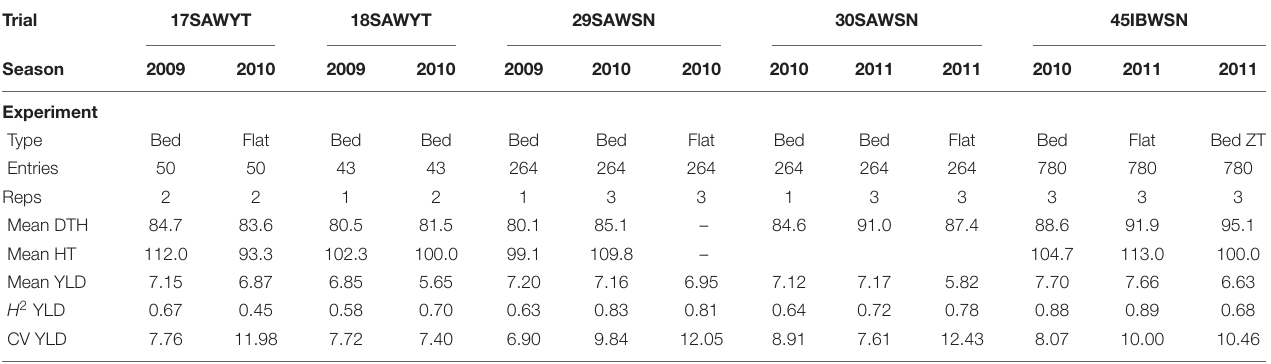
TABLE 1 | Training set experiments summary data.